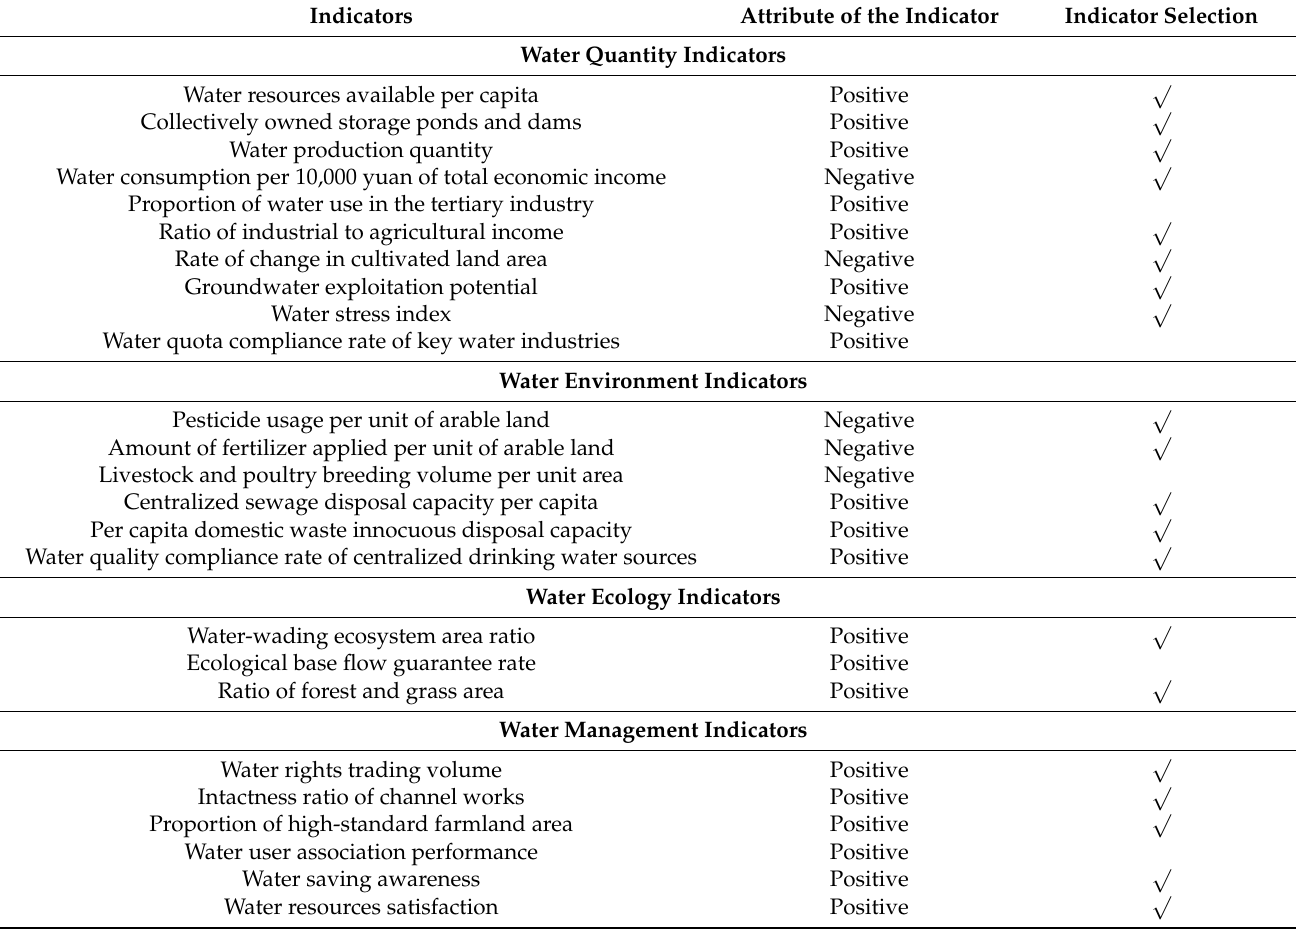
Table A1. Selection of evaluation indexes of WRCC for towns in Ganzhou